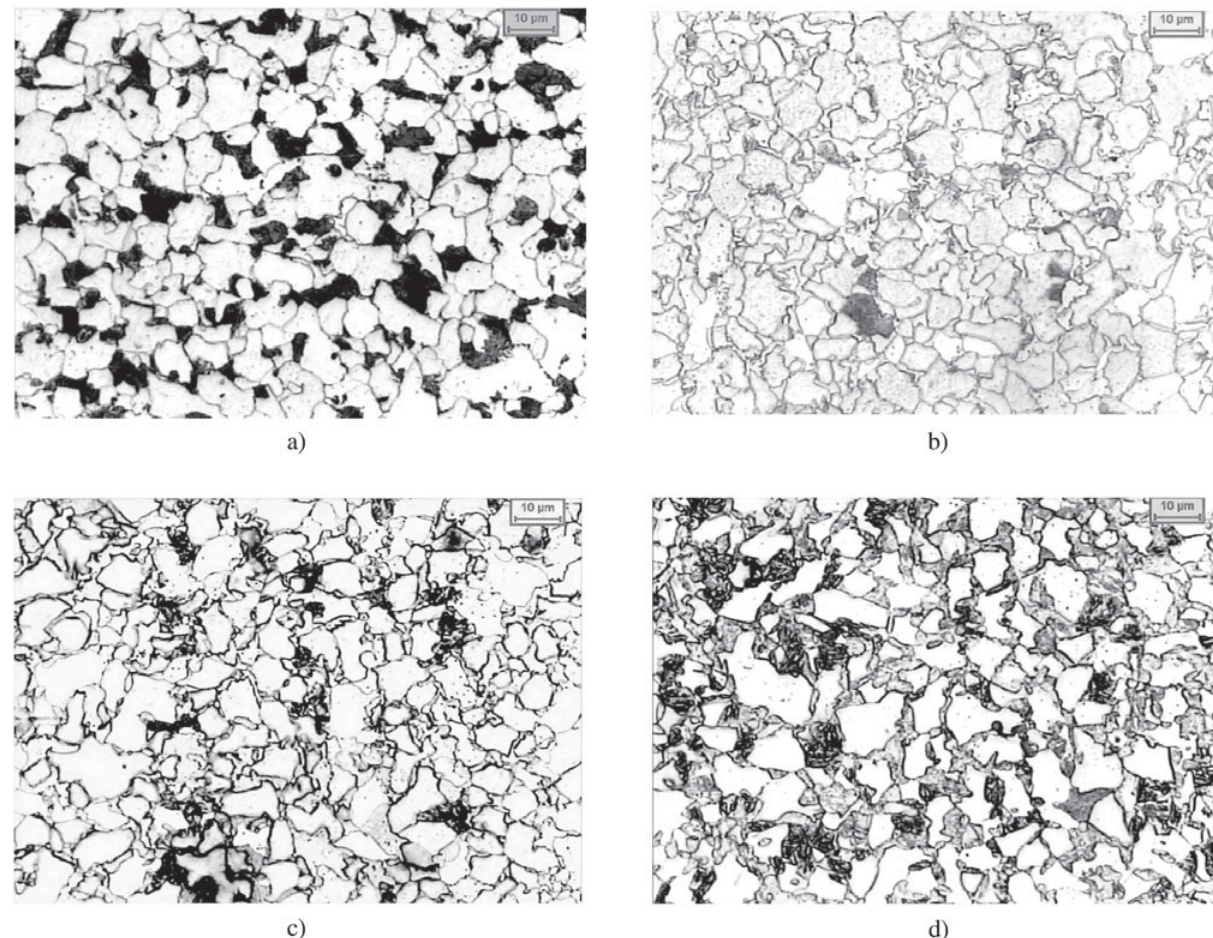
Figure 2. Optical micrographs (1000 ×) of samples after (a) normalization; intercritical at 750 °C for (b) 300s; (c) 600 s, (d) 1800 s.